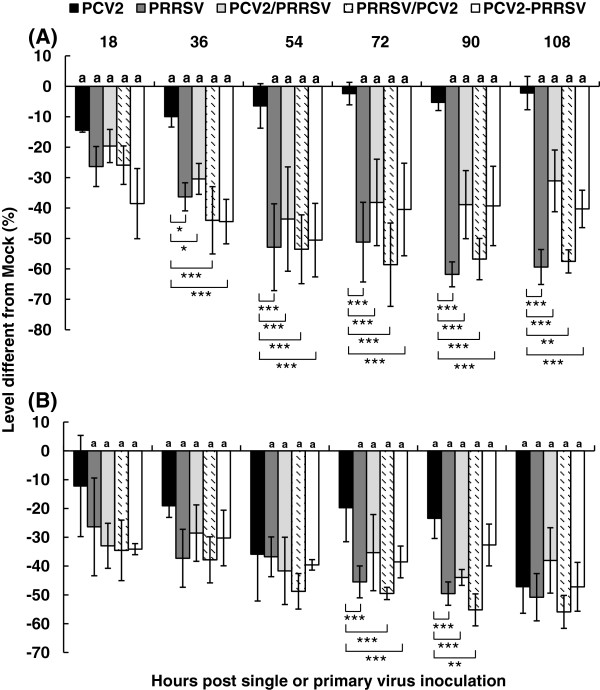
Changes in phagocytotic and microbial killing capabilities of swine alveolar macrophages (AMs). Changes in (A) phagocytotic and (B) microbial killing capabilities in PCV2- and/or PRRSV-inoculated swine alveolar macrophages (AMs) were determined by using Candida albicans as the target. Following 60 min of incubation and staining with acridine orange, the percentages of viable AMs with engulfed yeasts and killed yeasts were determined. Data are expressed as the level different from that of the mock-inoculated AMs (Mock) and shown as mean ± SD of three independent experiments. PCV2: AMs inoculated with PCV2 alone; PRRSV: AMs inoculated with PRRSV alone; PCV2/PRRSV: AMs inoculated with PCV2 first then inoculated with PRRSV 18 h later; PRRSV/PCV2: AMs inoculated with PRRSV first then inoculated with PCV2 18 h later; PCV2-PRRSV: AMs co-inoculated with PCV2 and PRRSV simultaneously. * (P < 0.05), ** (P < 0.01), *** (P < 0.001)The difference between the two treatment groups at the same h post inoculation (HPI) with the first virus is statistically significant. aValues are significantly different from the Mock at the same h post inoculation (HPI) with the first virus.